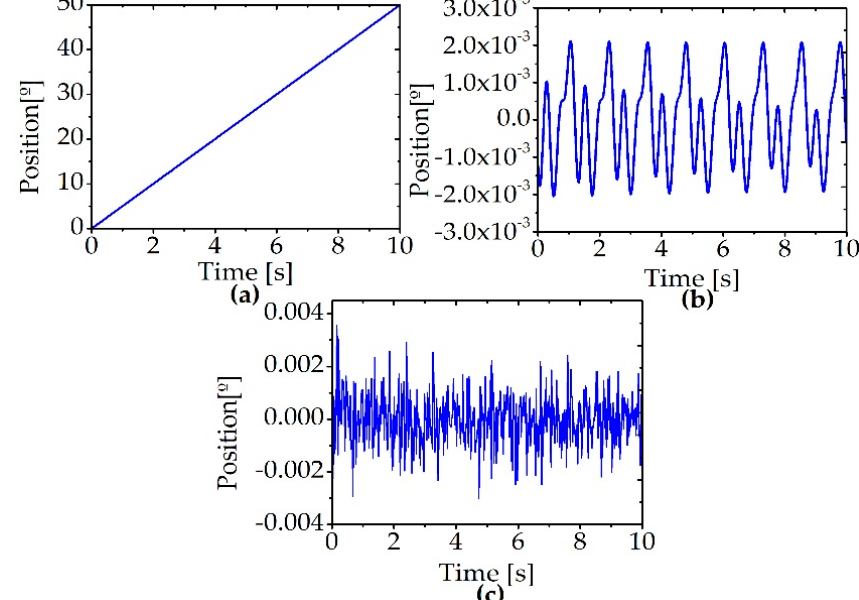
Figure 4. The emulated signal consists of ( a ) trend, ( b ) cyclic oscillations and ( c ) noise.